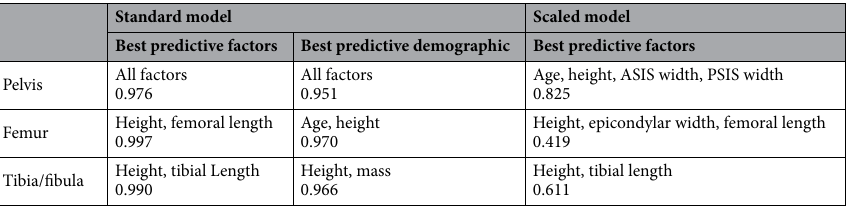
Table 3. The combination of predictive factors which produced the highest R 2 score in a partial least squares regression of the standard and scaled shape models. Where best predictive factors considered all factors: age, height, mass, sex, and length measurements. Best predictive demographic considered only age, height, mass, and sex for predictive factors.